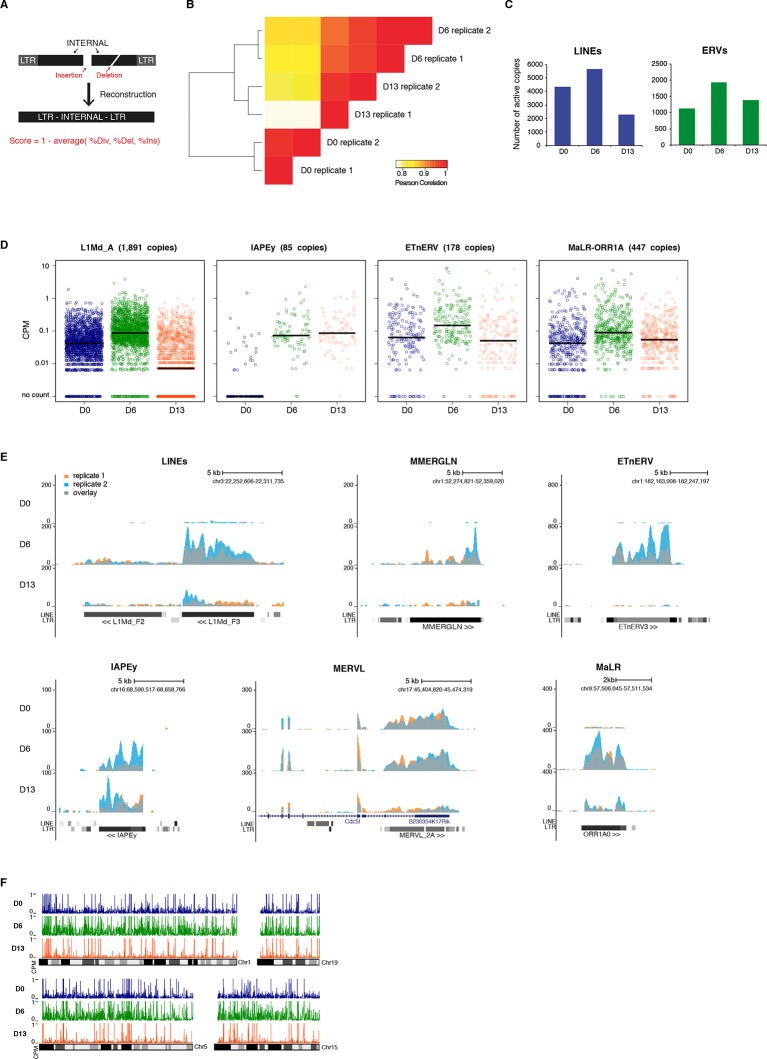
Genome-wide characterization of transposon relaxation.(A) Reconstruction principles of RepeatMasker annotation. (B) Pearson correlation and hierarchical clustering between RNA-seq experiments. (C) Number of individual LINEs and ERVs with detectable expression at D0, D6 and D13 of 2i+vitC conversion. Elements with a minimum of 10 uniquely mappable reads were considered. (D) Expression of individual elements from different transposon families at D0, D6 and D13 in Count per Millions (CPM). Each dot represents a single element. RNA-seq mapping allowed only unique hits in the reference genome and only elements that had a minimum of 10 reads in at least one of the sample were conserved. The black bar represents the median of the distribution. Analyzed numbers of distinct transposon copies per family appear into brackets. (E) Representative genomic regions comprising LINE1 and ERV repeats. RNA-seq coverage for the two biological replicates is represented in blue and orange, and the overlap in grey. Data represent normalized read density. (F) Expression of individual transposable elements and their localization on chromosomes 1, 5, 15 and 19 at D0, D6 and D13 of conversion. Each bar represents the expression of a single element in Count per Millions (CPM). Elements with a minimum of 10 uniquely mappable reads in at least one sample were considered.